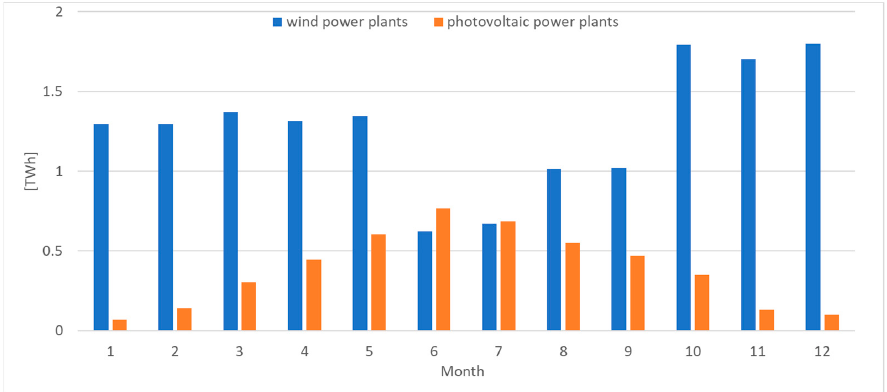
Figure 7. Energy generation by photovoltaic and wind power plants in monthly values in Poland in 2021 (own compilation of data from PSE S.A.).